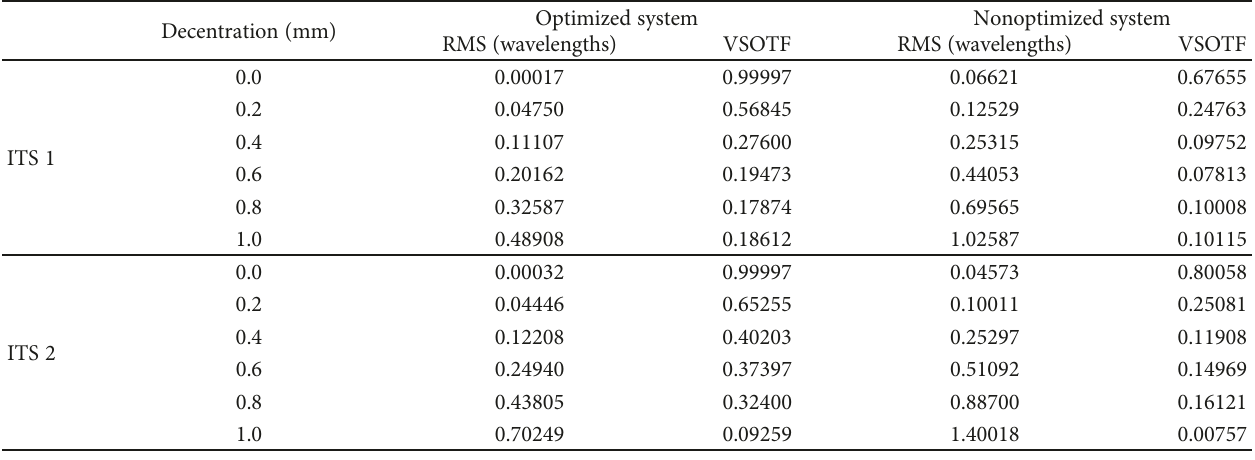
Table 1: Optical and visual results for both telescopic systems (far target distance).